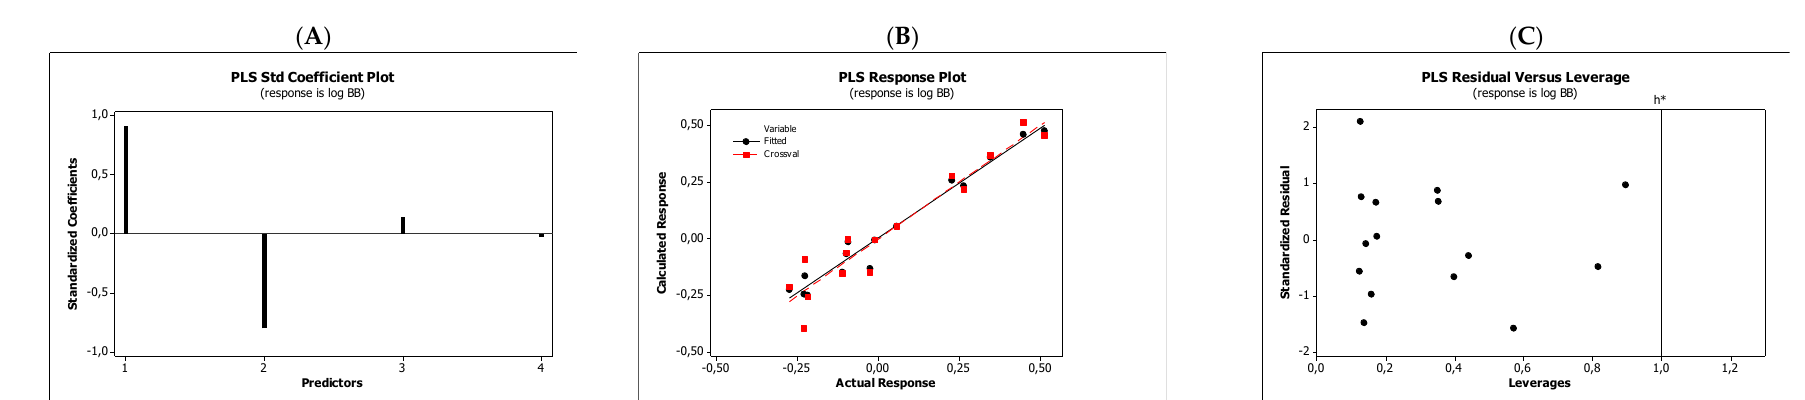
Figure 10. Standardized coefficients ( A ), the correlation between actual and predicted log BB parameters ( B ), and the Williams plots ( C ) of Equation (9).